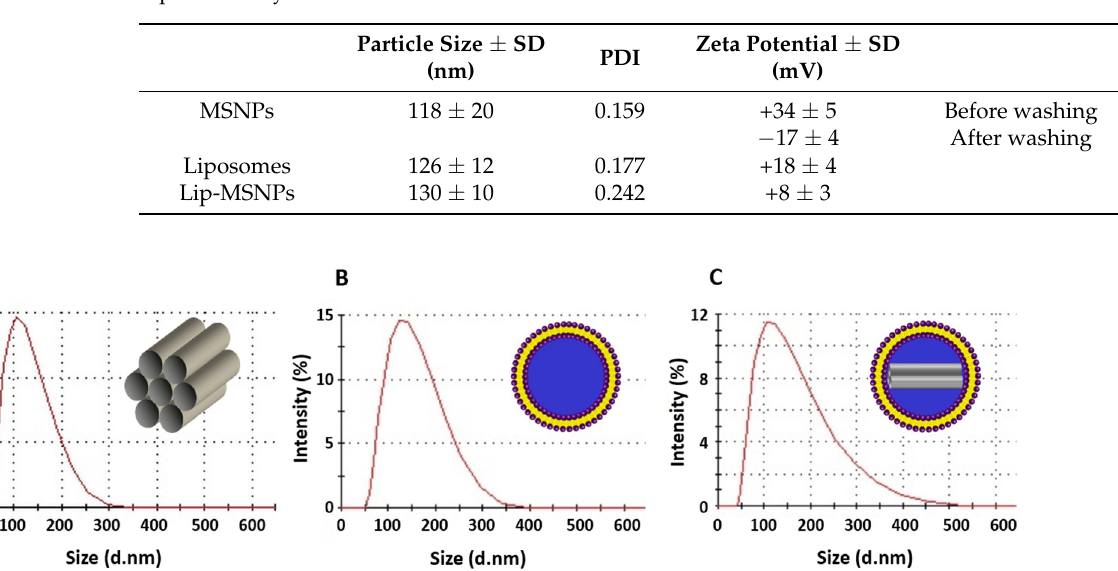
Figure 2. DLS measurements for size distribution of ( A ) MSNPs, ( B ) Liposomes, and ( C ) Lip-MSNPs.